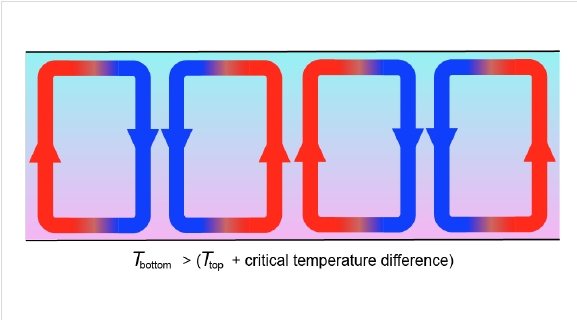
Figure 5: The Raleigh–Bénard instability. Convection takes place in a liquid layer provided that the temperature difference between the bottom and the top of the layer exceeds a threshold